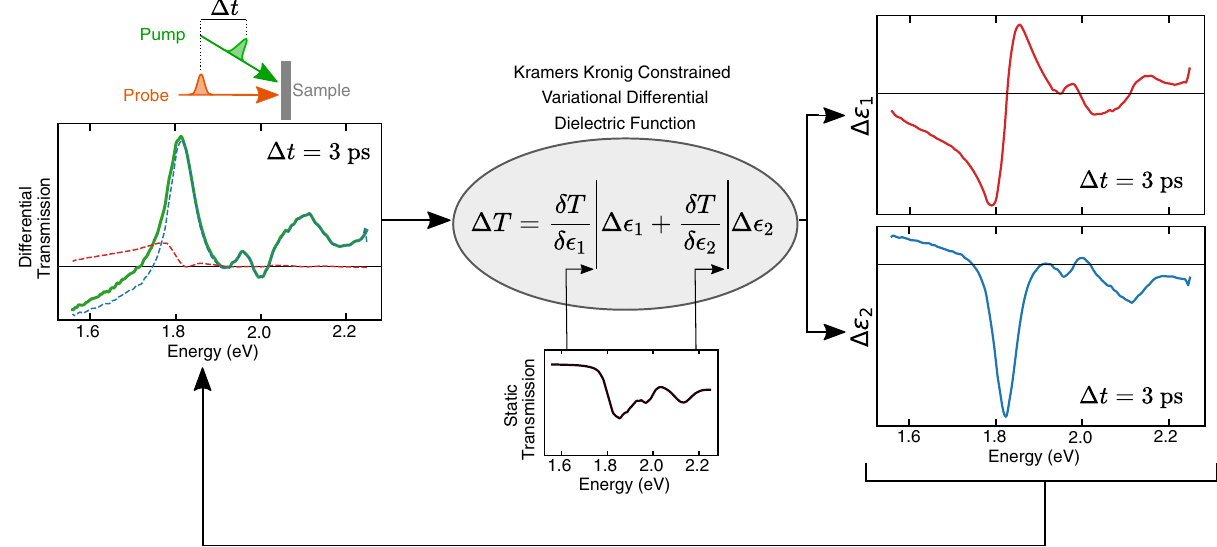
Fig. 1 Schematic of the Kramers – Kronig based analysis technique. Here, equipped with the differential spectra of a pump probe experiment (green) and the static spectrum (black), one can extract quantitative changes in the transient complex dielectric function (red and